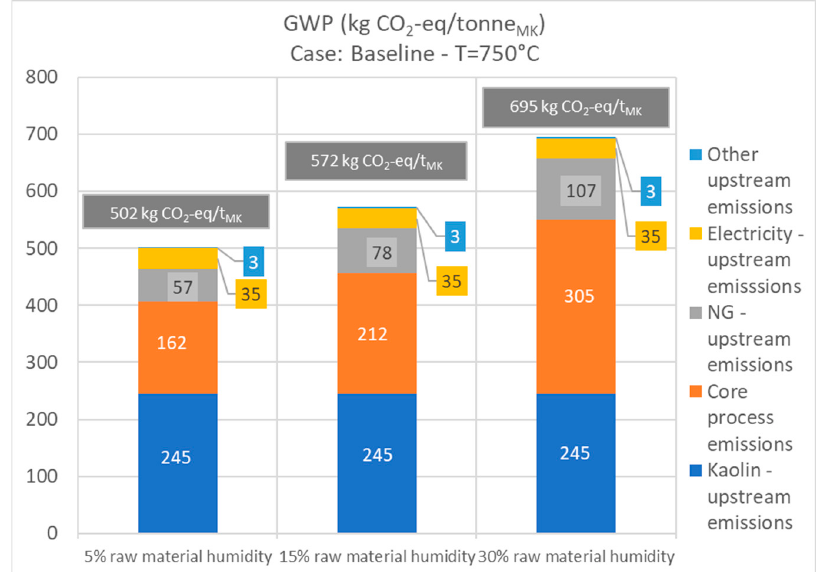
Figure 11. Influence of kaolin humidity on the lifecycle